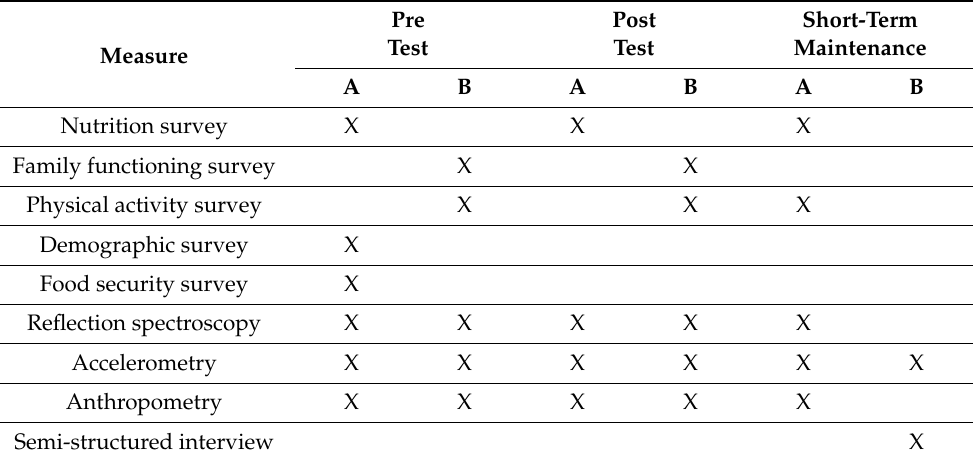
Table 7. Measures and timing for the